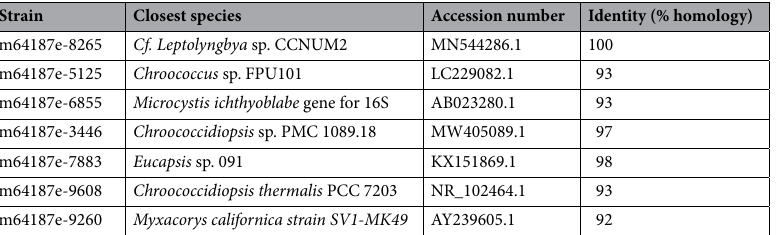
Table 5. Blast search results for cyanobacterial strains used in the present study based on 16S rRNA sequence data.